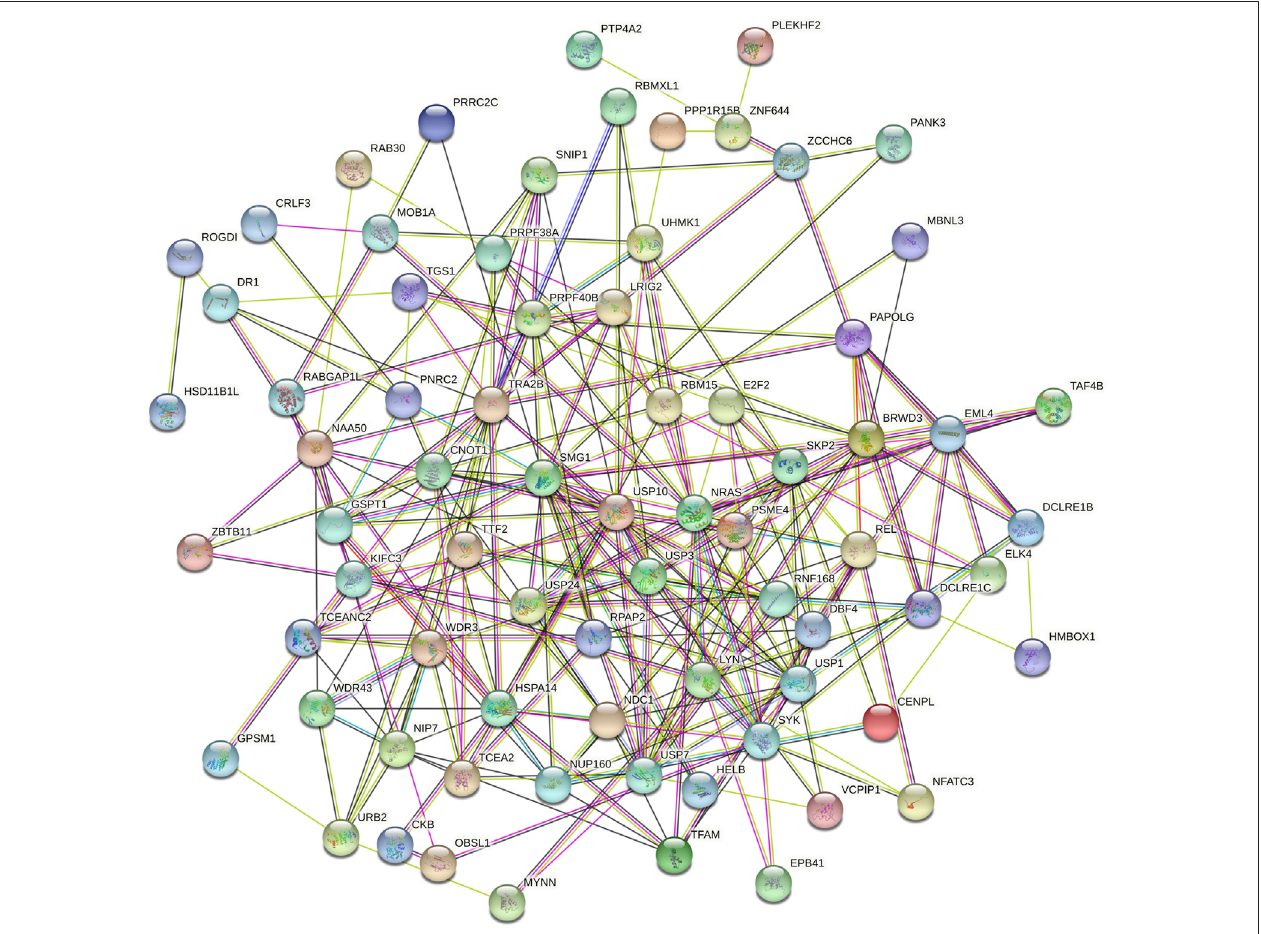
FIGURE 10 | The PPI network of RBM15 and its 82 co-expression genes from STRING database.